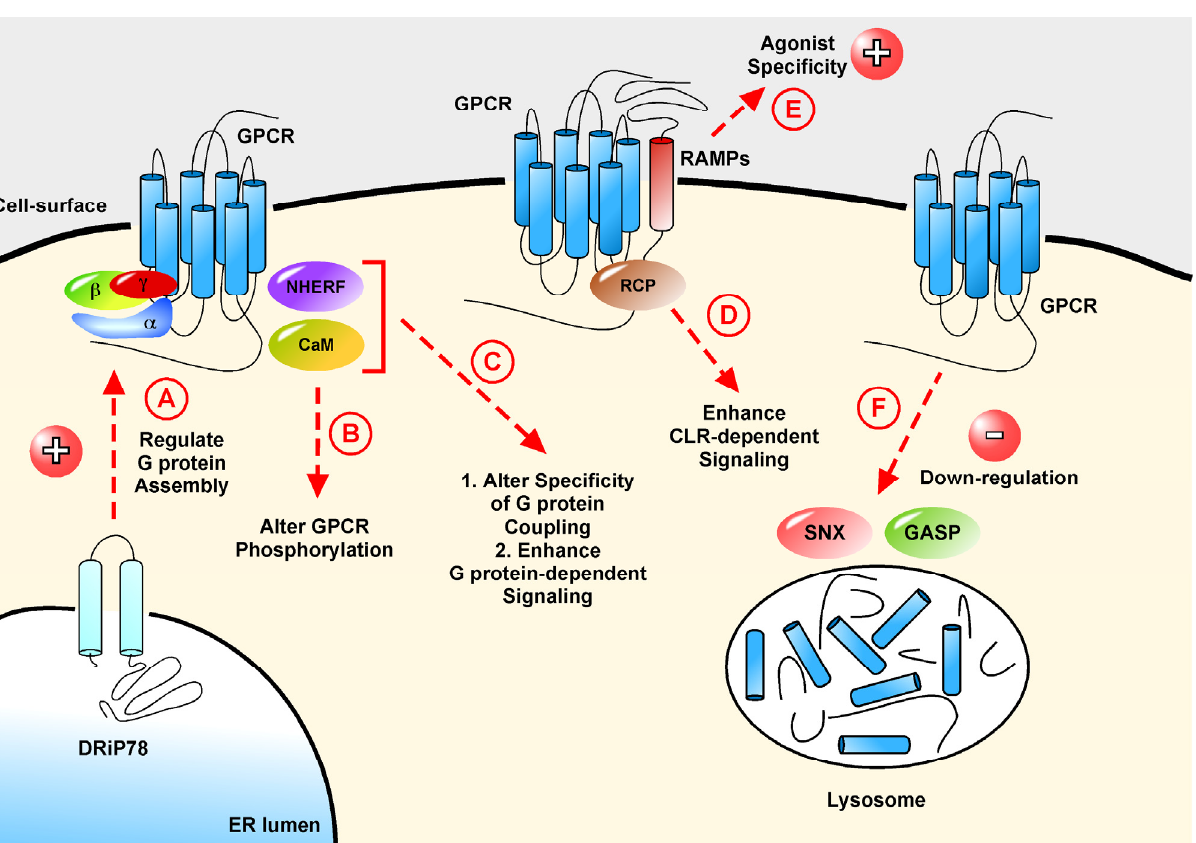
Figure 2. Schematic representation of the roles of GPCR interacting proteins in the signaling and trafficking of GPCRs from the cell-surface. ( A ) DRiP78 coordinates